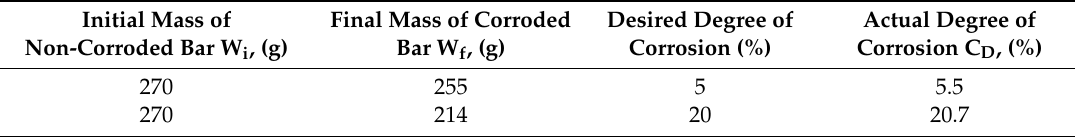
Table 2. Desired and actual degree of corrosion of corroded steel